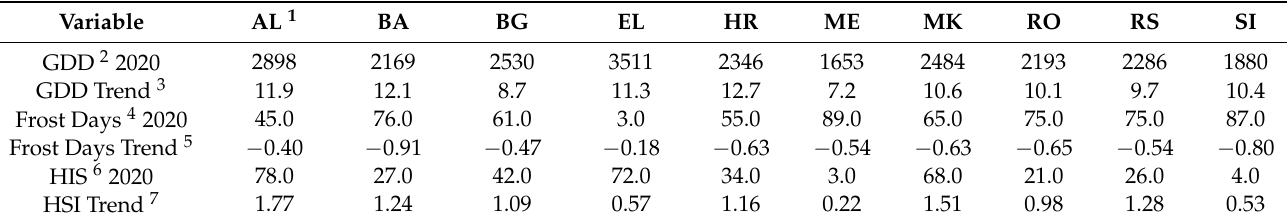
Table 3. The medians per variable and country for wheat cultivation.